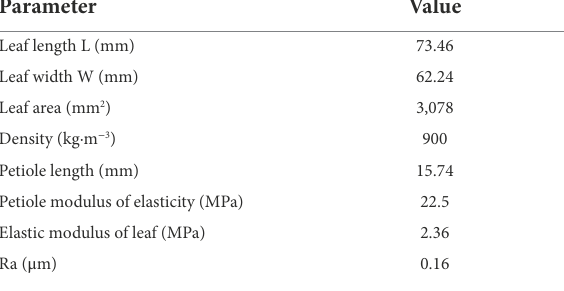
TABLE 1 Sample size and physical